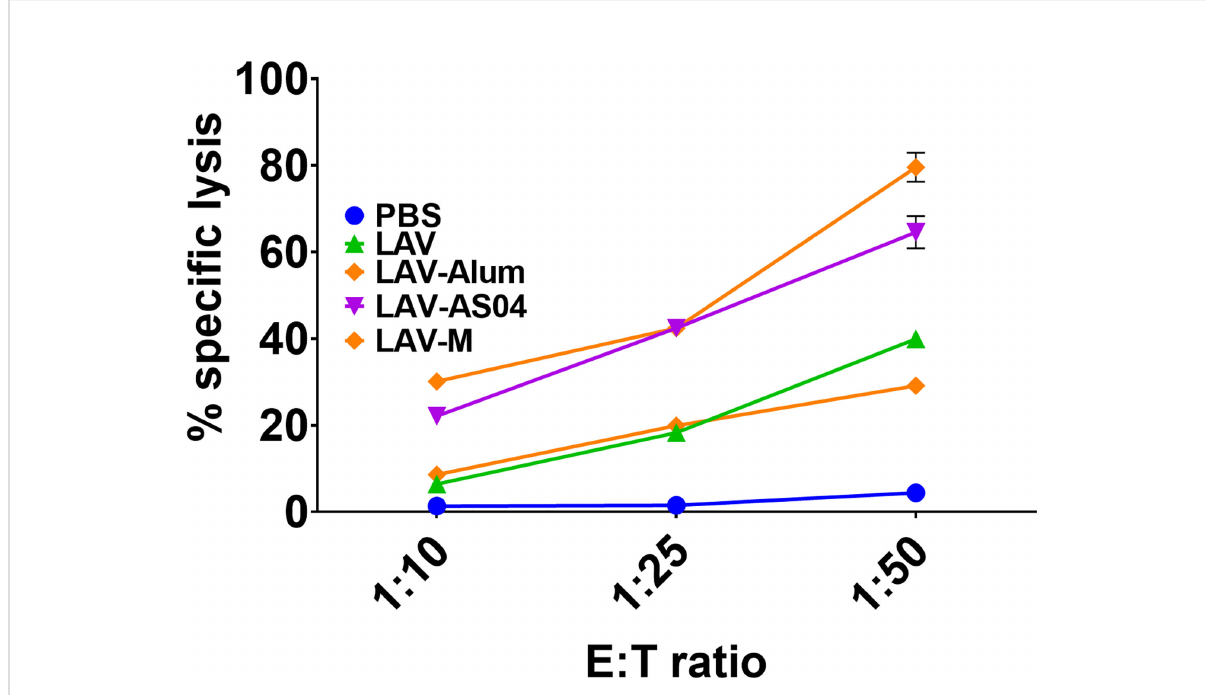
FIGURE 2 Cytotoxic T-cell response induced by various vaccines. Effector cells generated in vitro from splenocytes isolated from various groups were added to speci fi c targets (DCs pulsed with LAV) in varying E:T ratios. Cytotoxicity was measured using a Cytotox kit (LDH method) following the manufacturer ’ s instructions. Data are representative of three different